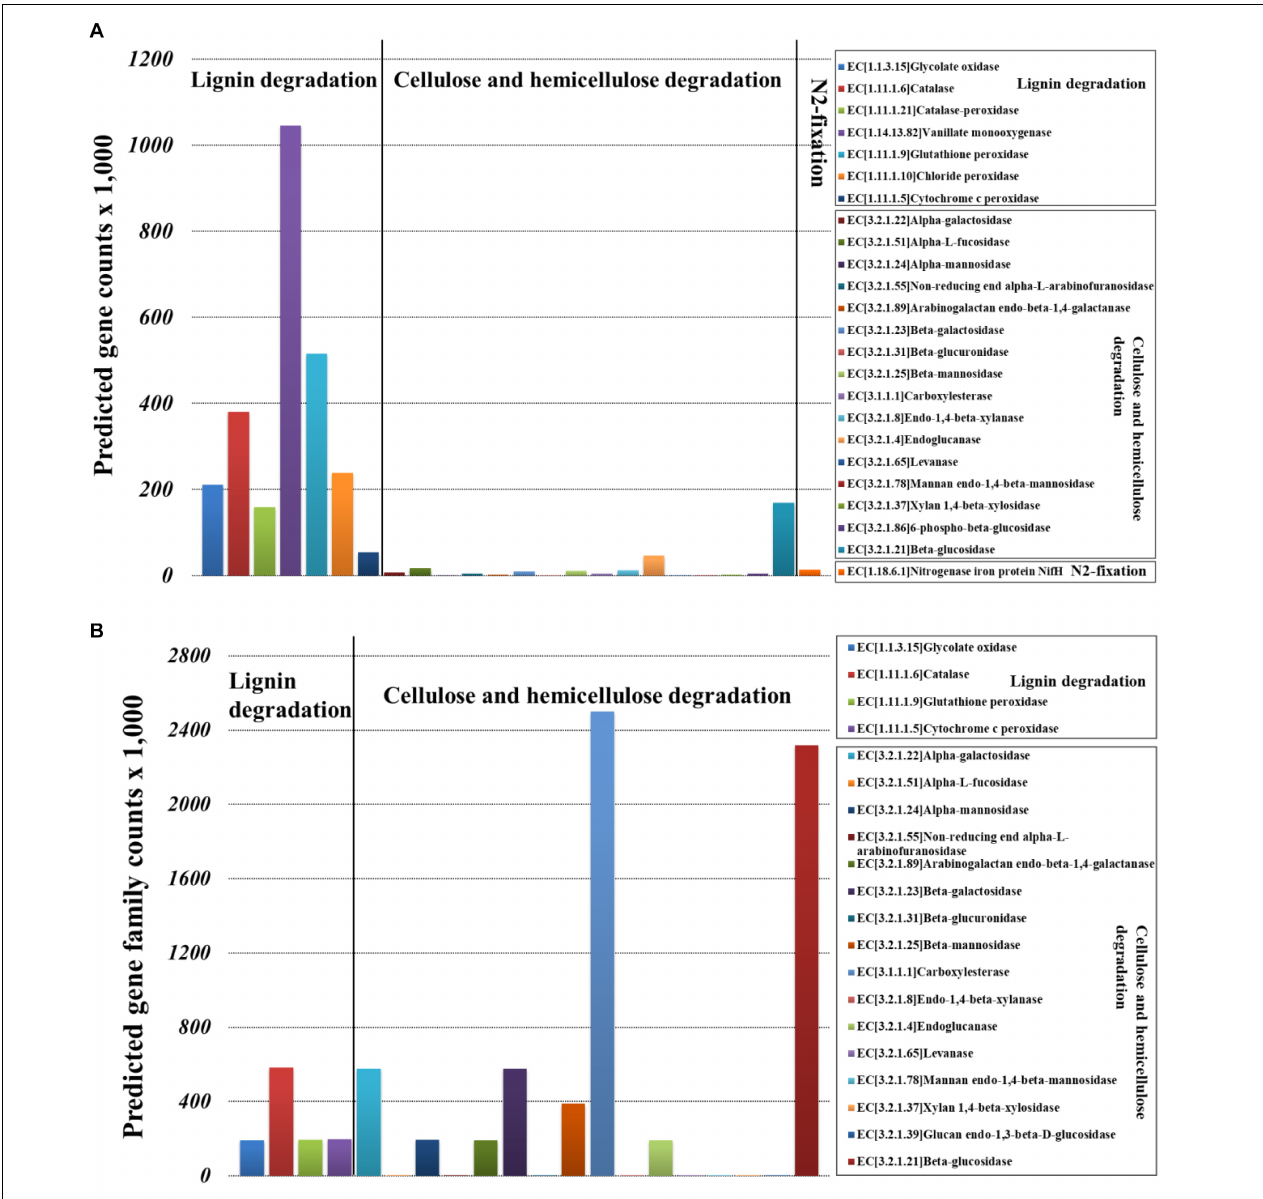
FIGURE 7 | Selection of genes involved in the lignocellulose degradation and nitrogen fixation of Sirex noctilio larval gut. (A) Bacterial and (B) fungal communities (the sum number of predicted gene family